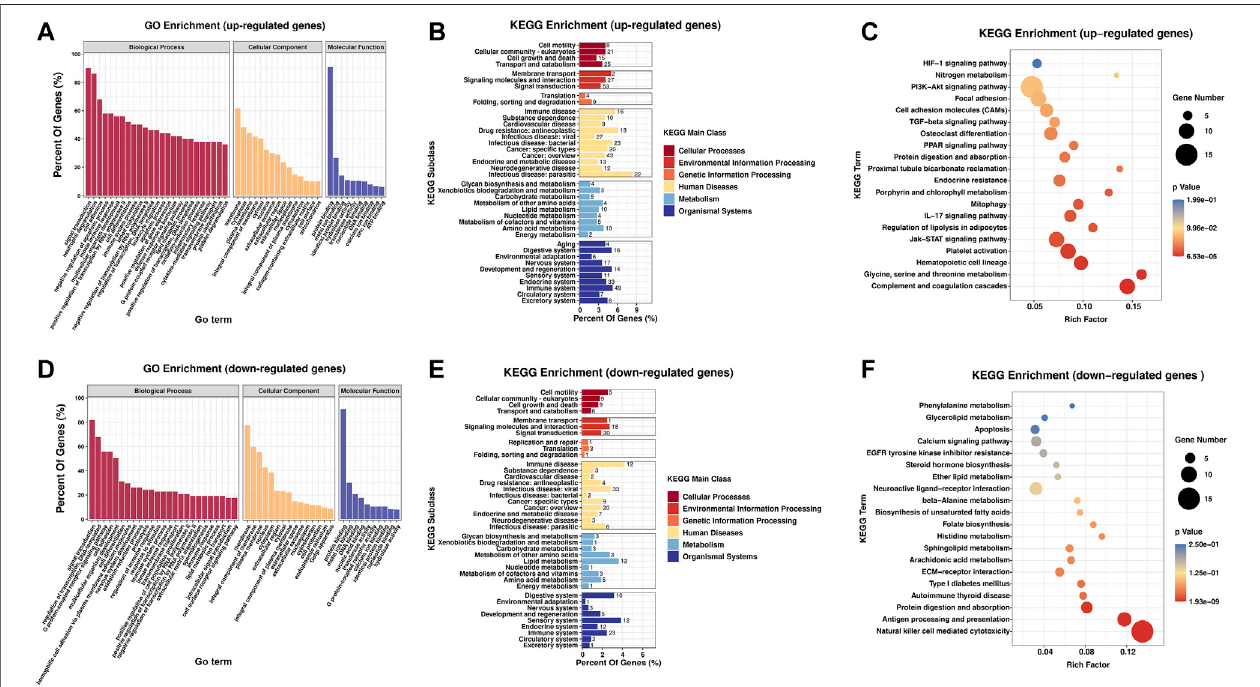
FIGURE 4 | Biological function and pathway analysis of differentially regulated genes between the RA and Con groups. (A) GO enrichment analysis of the upregulated genes with great diversity. (B) KEGG enrichment subclass exploration of the upregulated genes with signi fi cant differences. (C) Top 20 KEGG pathway enrichments of the upregulated genes with great diversity. (D) GO enrichment exploration of the signi fi cantly downregulated genes. (E) KEGG enrichment subclass exploration of the highly downregulated genes. (F) Top 20 KEGG pathway enrichments of the signi fi cantly downregulated genes. RA, rheumatoid arthritis; Con, control group; GO, Gene Ontology; and KEGG, Kyoto Encyclopedia of Genes and